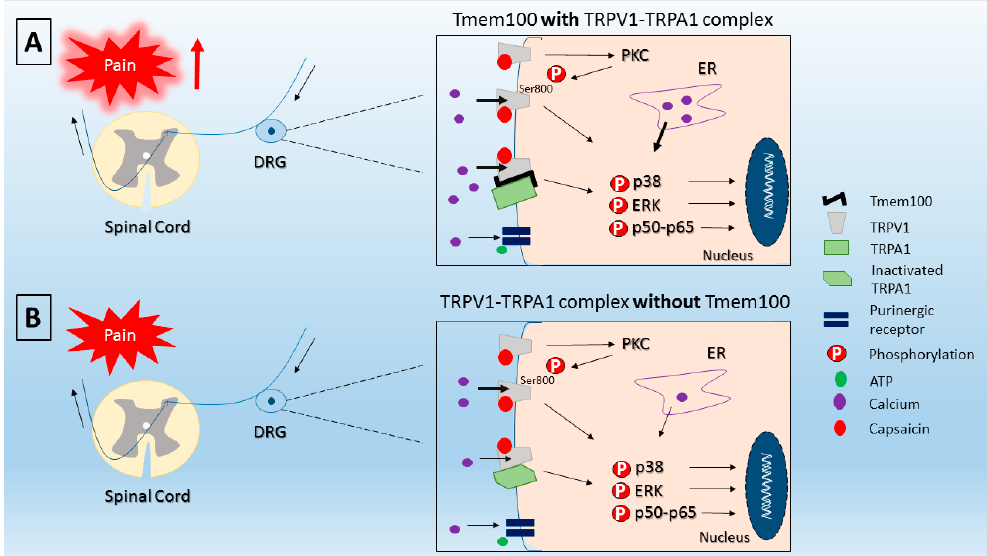
Figure 2. Mechanisms of capsaicin-induced pain. Schematic representation of the phosphorylation at Ser800, which allows TRPV1 discriminating cation influx [50], and participation of Tmem100 in the mechanism of capsaicin-induced pain [49,51,52]. In the presence of Tmem100 ( A ) activation of TRPV1-TRPA1 complex increases the influx of calcium and contributes to higher perception of pain. On the other hand, without Tmem100 ( B ) TRPV1-TRPA1 complex produces lower influx of calcium since TRPA1 is found in an inactivated conformation [49,51,52]. Black thin arrow: lower calcium influx; Black thicker arrow: higher calcium influx; DRG: dorsal root ganglion; ER: endoplasmic reticulum; PKC: protein kinase